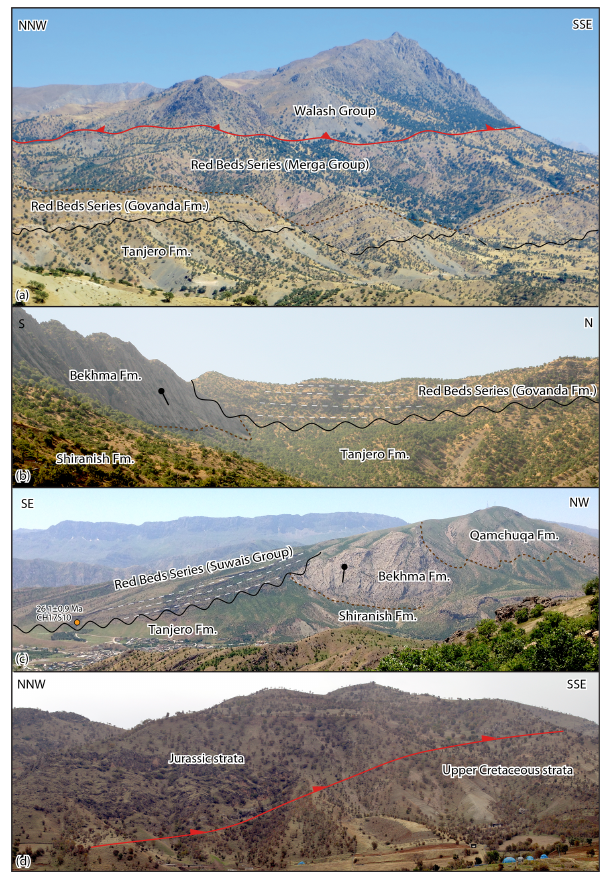
Figure 5. Landscape photographs showing field relationships. (a) The transported Paleogene Walash Group thrusted onto the Miocene units of the Red Beds Series that deposited on the Maas- trichtian Tanjero Formation. (b) Angular unconformity between the middle-Miocene Govanda Formation of the Red Beds Series and the folded Cretaceous units. (c) Angular unconformity between the upper-Oligocene–lower-Miocene (?) Suwais Group of the Red Beds Series and the folded Cretaceous units. (d) Thrust fault between the Lower Jurassic strata (Sehkaniyan Formation?) and the Upper Cre- taceous strata (Tanjero Formation).